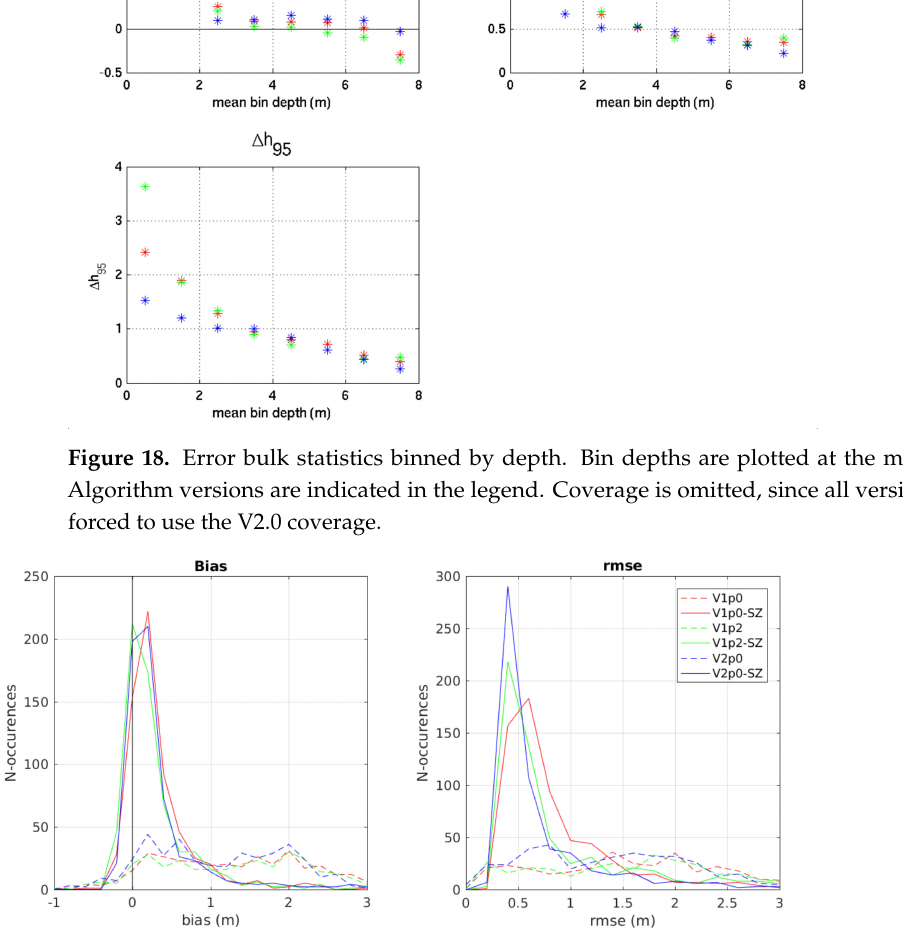
Figure 19. Histograms of the bias ( left ) and rmse ( right ) statistics for each of the three version of the cBathy algorithm (see legend). The data have been partitioned into non-breaking regions (solid lines) and surf zone regions (dashed lines; legend has “SZ”